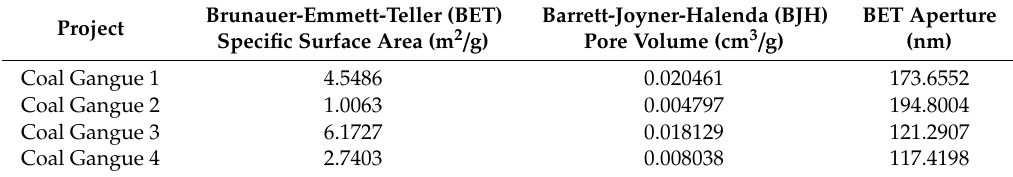
Figure 9. Nitrogen adsorption desorption isotherm of Coal Gangue 1–4. Table 3. Comparison table of specific surface area and pore volume of Coal Gangue